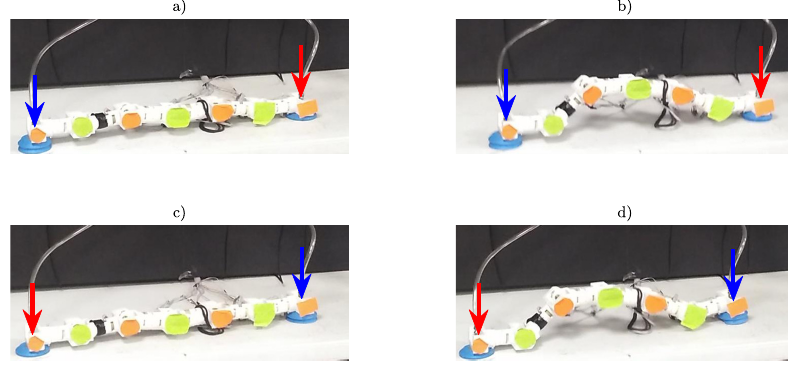
Figure 14. Reference framework switching: ( a ) second vacuum pump activated (red arrow) in zero position; ( b ) second vacuum pump activated during gait cycle; ( c ) first vacuum pump activated in zero position; ( d ) first vacuum pump activated during gait